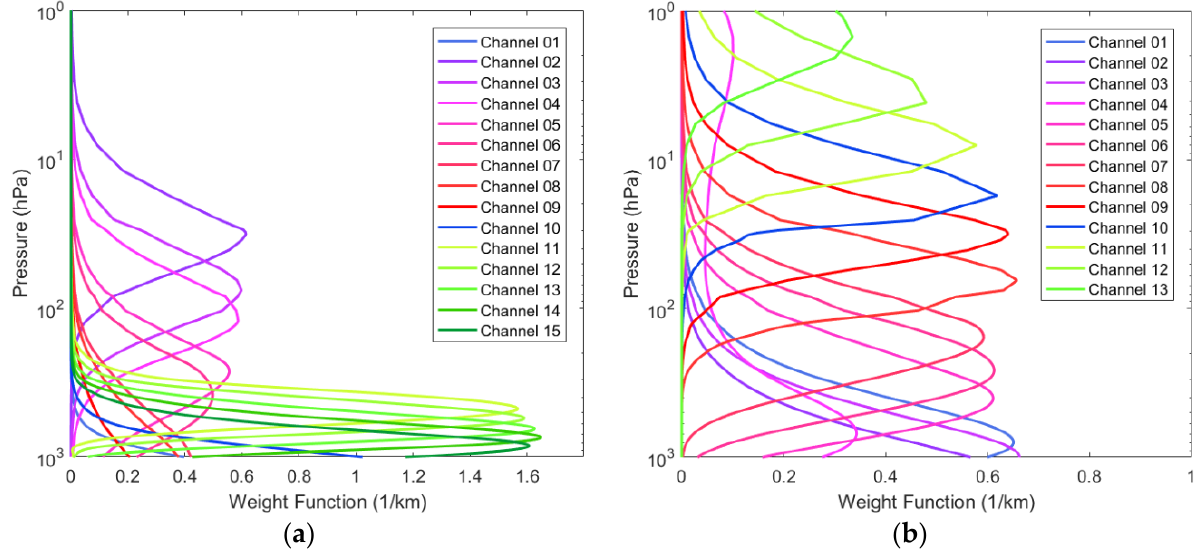
Figure 1. Weighting functions for MWHTS and MWTS-II calculated from the U.S. standard atmos- pheric profile at nadir, assuming a surface emissivity of 0.6: ( a ) MWHTS; ( b ) MWTS-II.